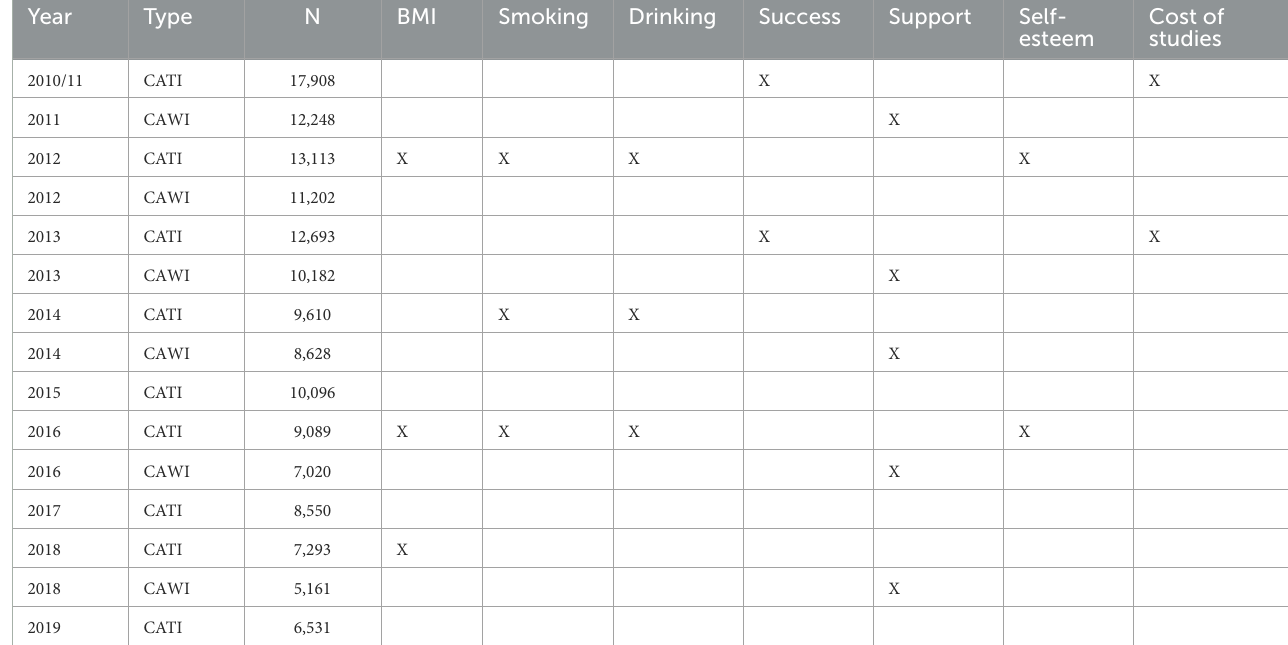
TABLE 1 Availability of key independent variables and original sample size for each